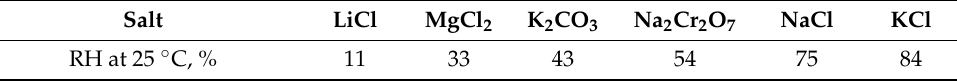
Figure 3. Scheme of the experimental setup. The general scheme of our setup is shown in inset ( A ). Included is an optical hygrocell with a controllable humidity level (1); a container with a saturated salt solution (2) equipped with a fan to ensure a steady spatial distribution of the moisture; a recirculating pump (3); a humidity sensor (4) installed in an empty container right before the inlet of the optical cell. The inset ( B ) is the scheme of the optical hygrocell: the body (1) of the cell was made of low-carbon structural steel; the window (2) was made of CaF 2 . It was glued to the body with epoxy resin. The examined samples were sprayed on the bottom of the replaceable window (3), also made of CaF 2 . The window (3) was sealed with a rubber gasket (4) and fixed by a steel cover (5). Moisturized air was supplied into the hygrocell through the central 1 mm-wide channel (6). ( C ) Photo of the optical hygrocell directly under the microscope objective. Table 1. A list of the saturated salt solutions and their corresponding relative humidities. Salt